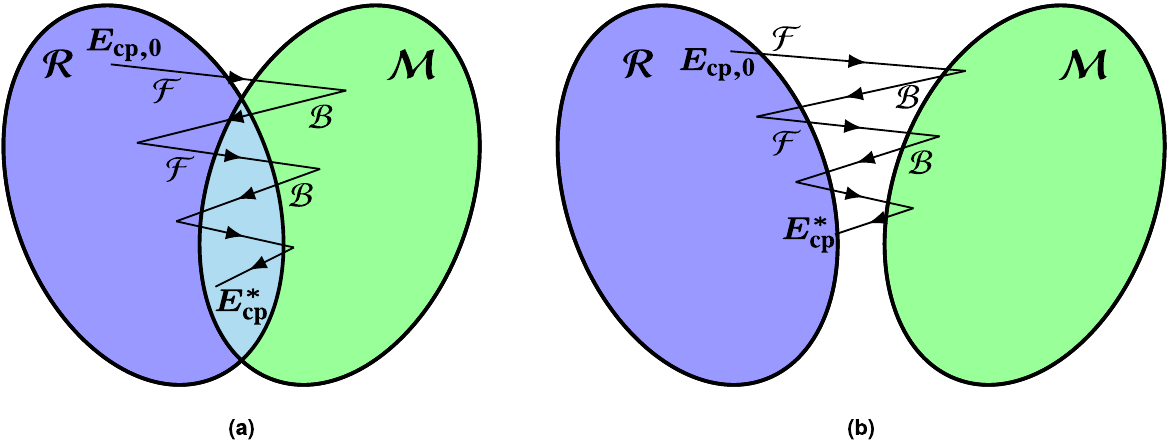
Figure 2. Schematic representation of the intersection approach optimization algorithm. This algorithm is iterative and considers two sets: the set of far fields that can be radiated by the antenna ( R ), and the set of far fields that comply with the specifications ( M ). Starting with an initial guess ( E cp,0 ), the algorithm applies two successive operations at each iteration: the forward projection ( F ) and the backward projection ( B ) until a solution E ∗ cp is reached if the two sets intersect ( a ), or the minimum distance if the intersection is void ( b